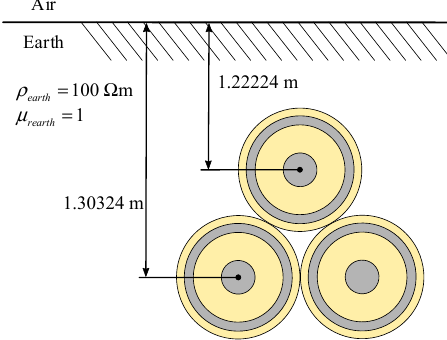
Figure 10. Cable cross-section for Case Study #2 and installation conditions (laying depth and surrounding medium properties). Source [31]. Table 4. Geometrical and material parameters for Case Study #2. Source [31].